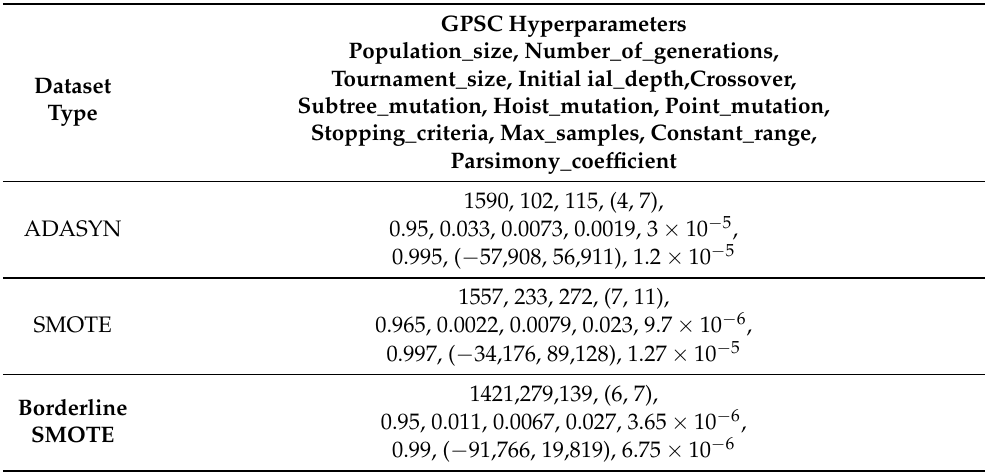
Table 5. The GPSC hyperparameters are used to obtain the best symbolic expressions on each dataset